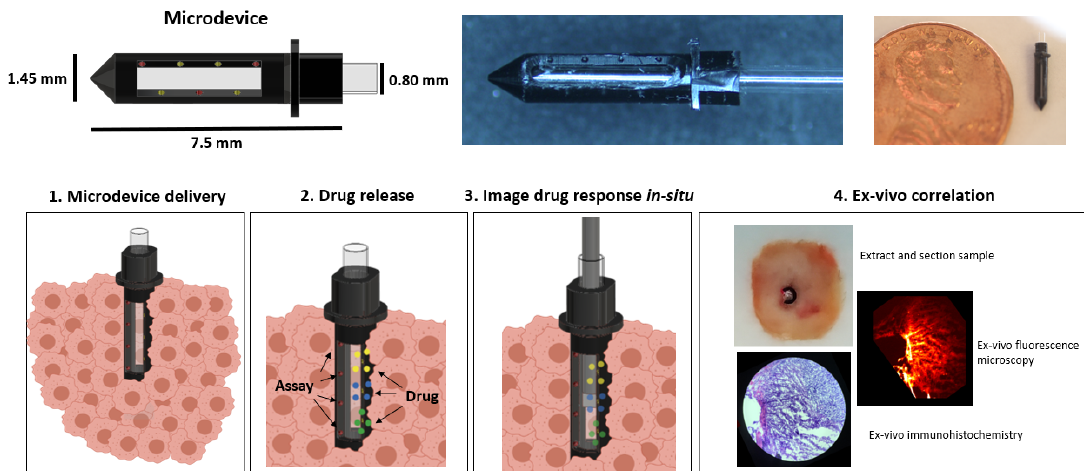
Figure 1. Schematic (top left) and actual image (top center and top right) of the lab-in-tumor implantable microdevice (LIT-IMD) containing multiple reservoirs for drug and assay release and a hollow inner lumen with optical window face. Bottom row demonstrates overall functionality: 1—LIT-IMD is implanted into a live tumor; 2—LIT-IMD releases multiple drugs into discrete confined tumoral tissue and in parallel, releases fluorescent cell death assay into drug-exposed tissue; 3—fluorescence imaging probe is passed coaxially into the LIT-IMD for real-time evaluation of drug diffusion and cell death response; 4—correlation was performed to validate this method by removing and sectioning tissue at each drug-exposed site and comparing in situ fluorescence imaging signal with conventional benchtop fluorescence microscopy and immunohistochemistry of processed tissue sections.